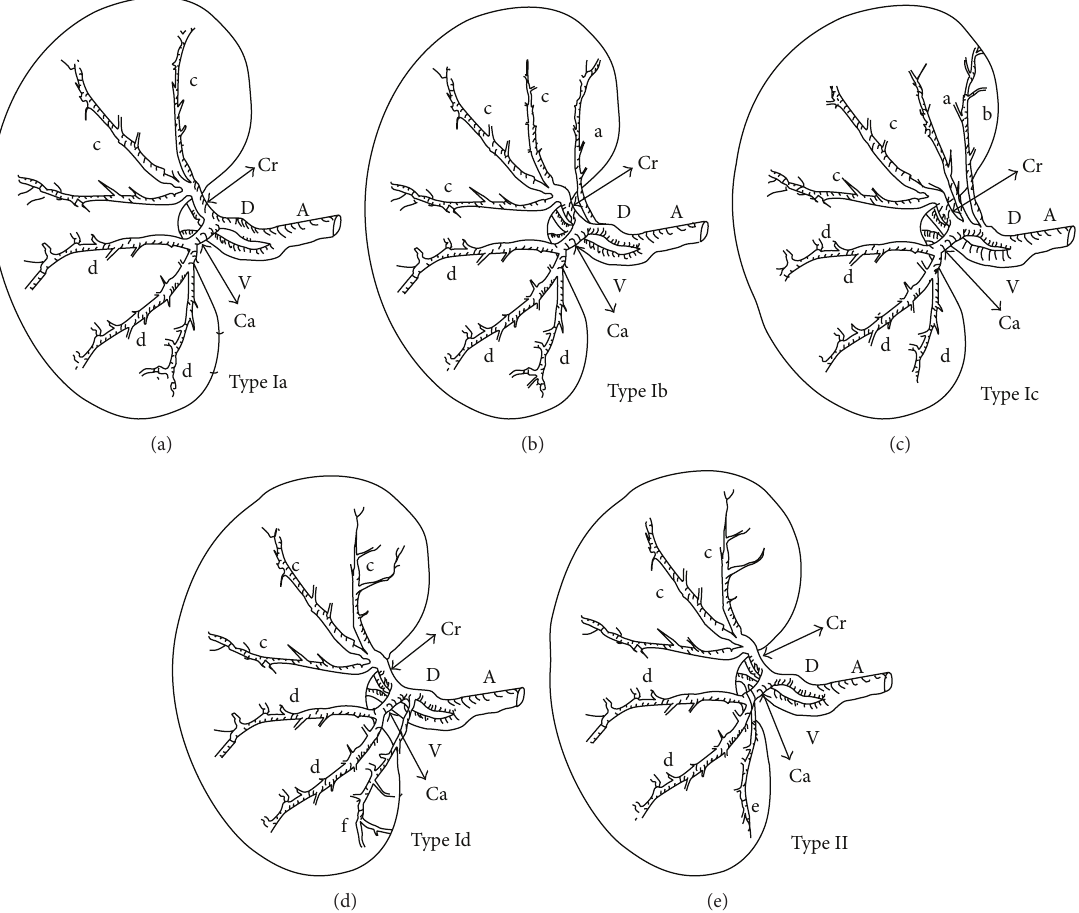
Figure 1: Schematic drawings of arteries of rat kidneys, illustrating the branching patterns of the different types of either the dorsal or ventral divisions of the renal artery. A: renal artery; V: the ventral branch of renal artery; D: the dorsal branch of renal artery; Cr: the cranial division of the renal artery; Ca: the caudal division of the renal artery; a: first interlobar branch from the renal artery for the cranial pole; b: second interlobar branch from the renal artery for the cranial pole; c: interlobar branches from the cranial division of the renal artery; d: interlobar branches from the caudal division of the renal artery; e: extrainterlobar branch from the renal artery for the opposite pole; f: extrainterlobar branch from the renal artery for the caudal pole.